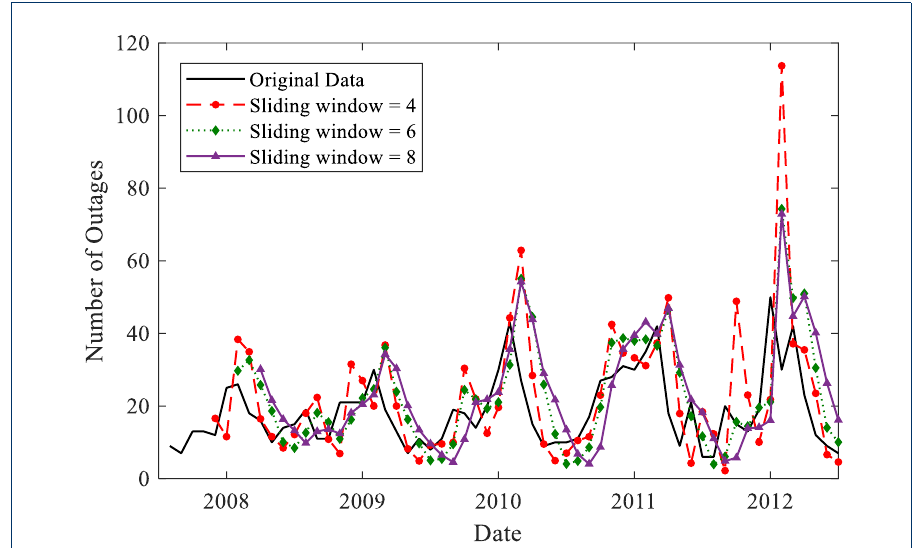
Figure 1 Results of monthly outage prediction with di(cid:11)erent sliding windows